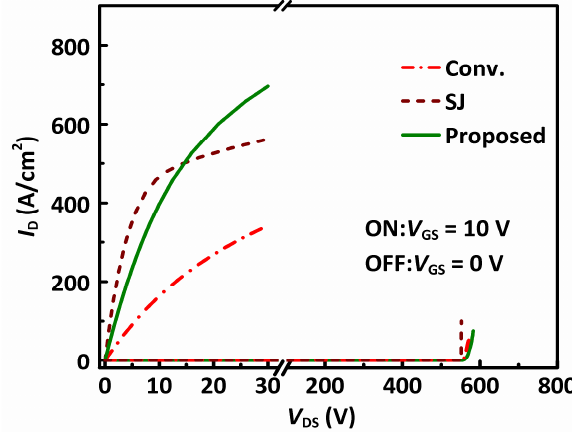
Figure 6. I-V characteristics of the studied MOSFETs.